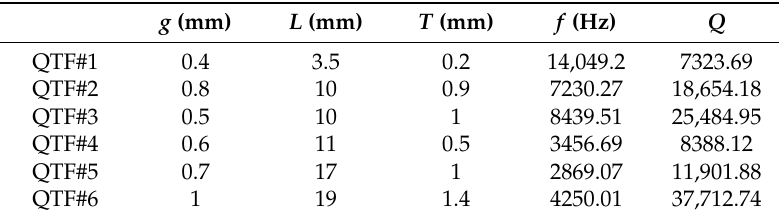
Table 1. Parameters of the first generation of the custom QTFs: Prong spacing ( g ), prong length ( L ), prong thickness ( T ), frequency ( f ) and quality factor ( Q ) in atmospheric pressure. g (mm) L (mm)